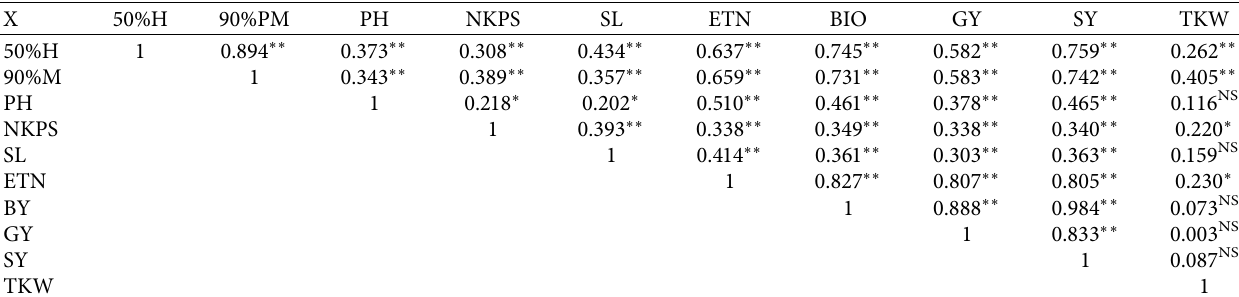
Kino CV LSD � list significant difference; CV � coefficient of variation. Table 10: Simple correlation analysis among growth, yield, and yield component parameters of malt barley at Debark, north Gondar, Ethiopia, in